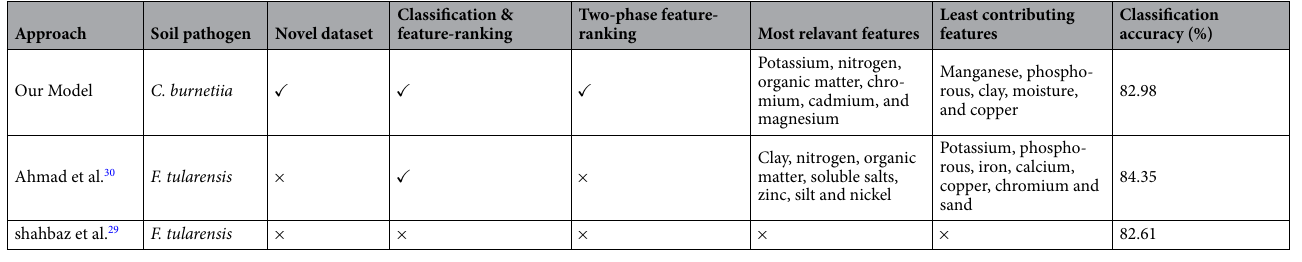
Table 7. Comparison with previous Machine learning